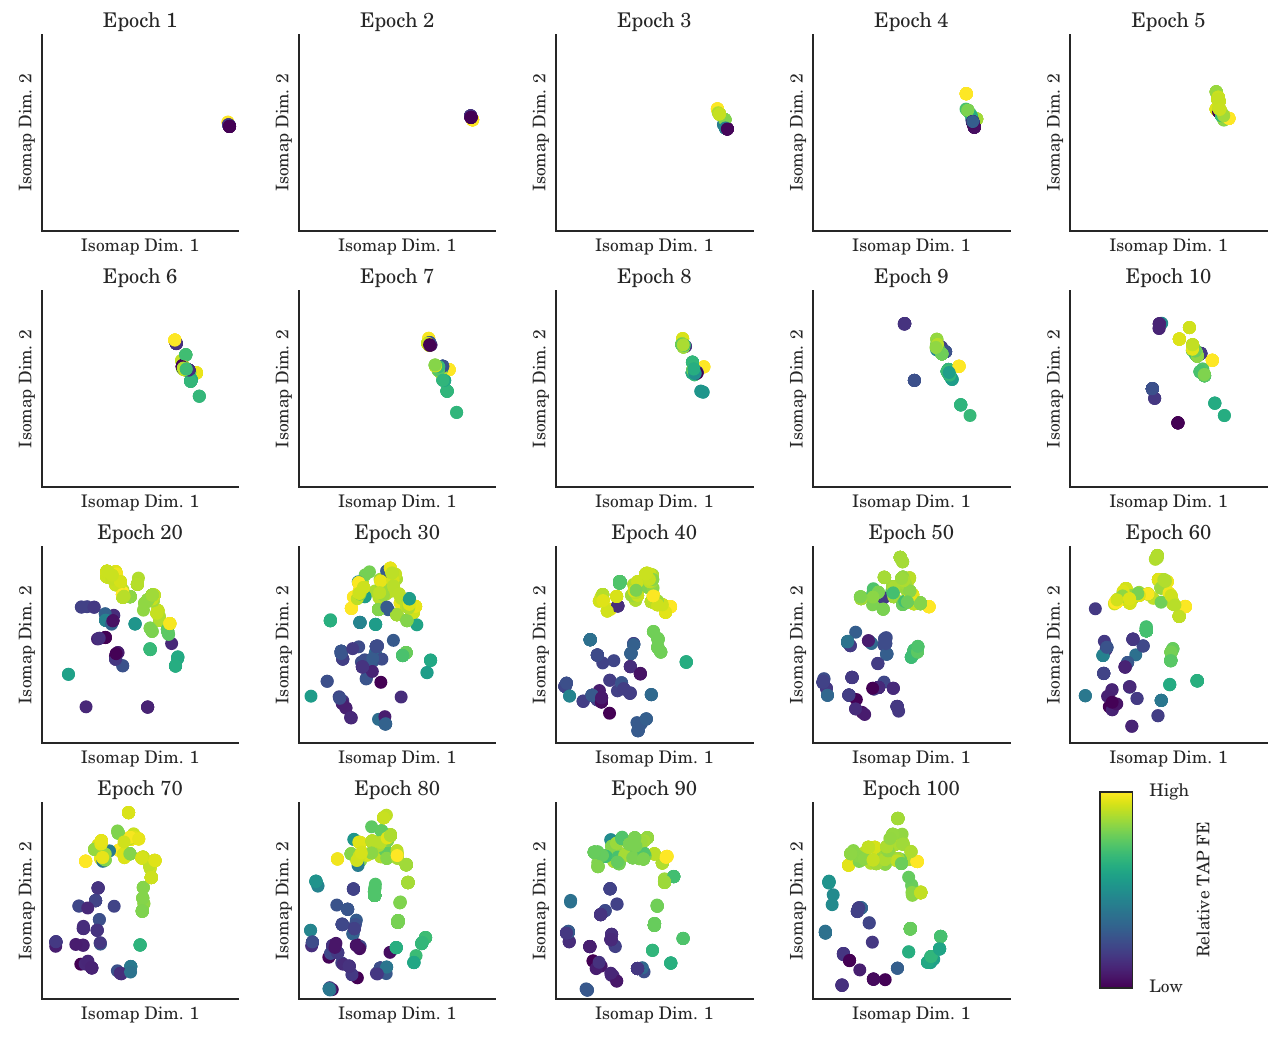
FIG. 6. Isomap visualization of TAP solutions for binary MNIST over training epochs for N h ¼ 100 . All TAP solutions are mapped to the same two-dimensional embedding via an Isomap transform fitted to the TAP solutions of epoch 100. The embedding is performed on both the hidden and visible inferred expectations a v and a h . The color mapping corresponds to the TAP free-energy values of each solution, with the range of colors normalized between the minimum and maximum free energies of the solution at each training